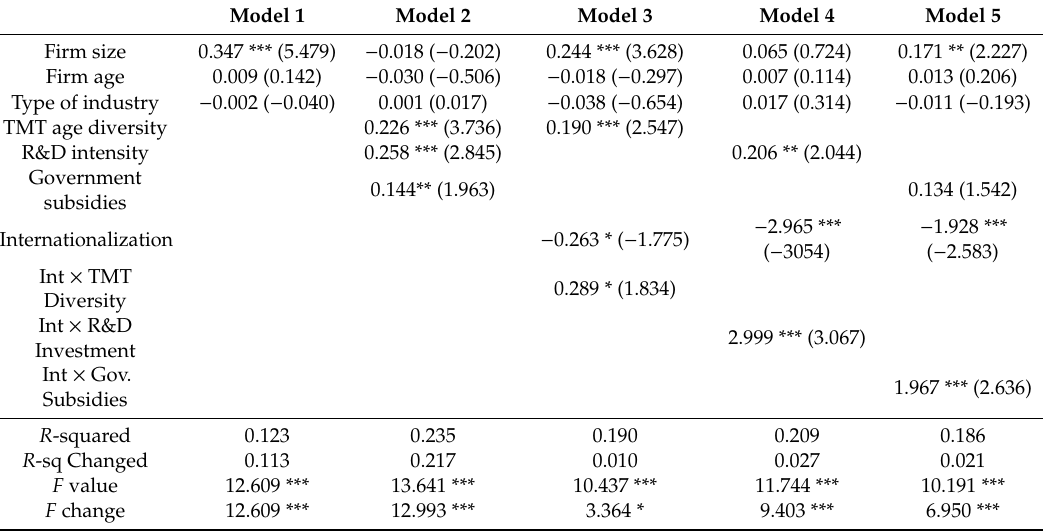
Table 2. Hierarchical multiple regression analysis results (n =